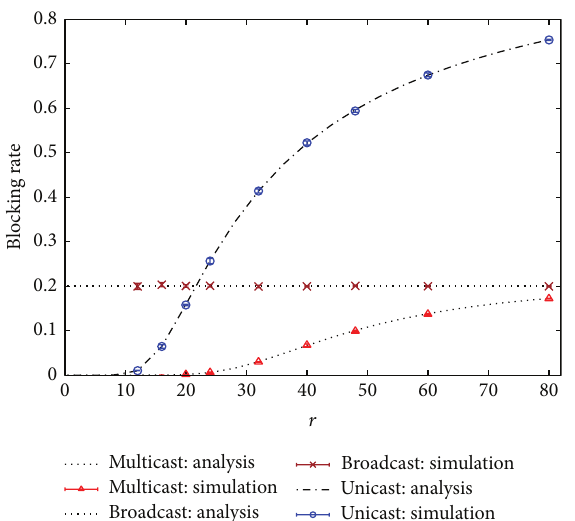
Figure 4: Blocking rates of unicast, broadcast, and multicast IPTV services. (Hit rate distribution: Zipf-like distribution with 𝑎 = 1 .)